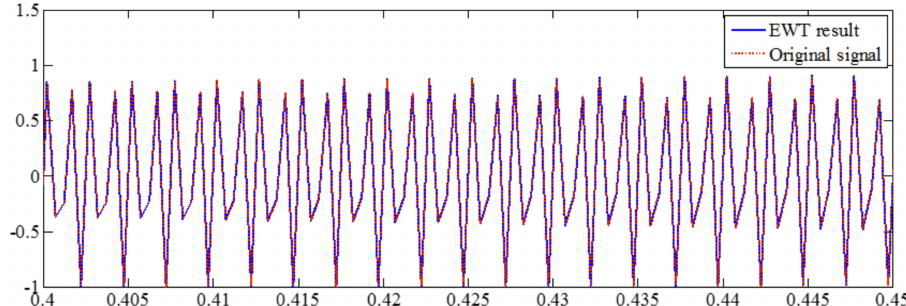
Figure 25. The EWT result and the original signal of 800 Hz within [0.4 0.45]